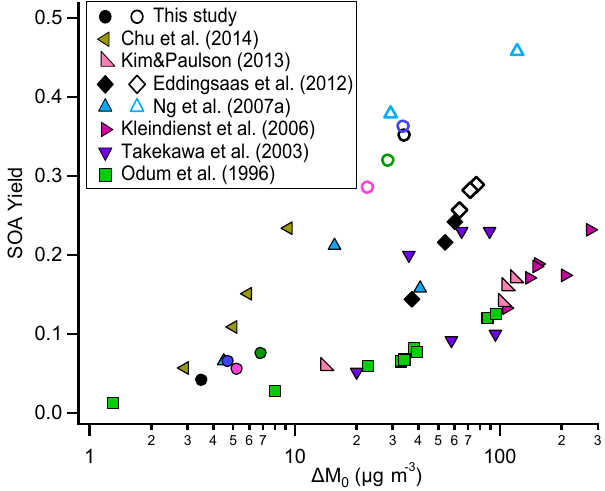
Figure 2. Comparison of final α -pinene SOA yields as a function of organic mass concentration ( (cid:49) M 0 ) under high- and low-NO x con- ditions in this study with those reported in literature. The solid and open symbols represent the SOA yields under high- and low-NO x conditions, respectively. The black, pink, blue, and green cycles rep- resent the SOA yield for experiments in this study with NH 4 / SO 4 molar ratios of 2.0, 1.0, 0.5, and 0.2, respectively. A factor of 1.6 was used to convert SOC yield and OC mass concentration to SOA yield and OA mass concentration in Kleindienst et al.